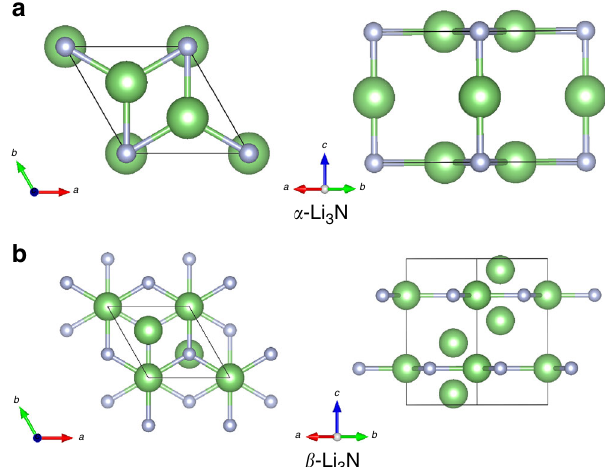
Fig. 1 Representation of the Li 3 N polymorphs considered in this study. a Sketch of the α phase from different views. b Sketch of the β phase from different views. Li and N ions are represented with green and blue spheres,